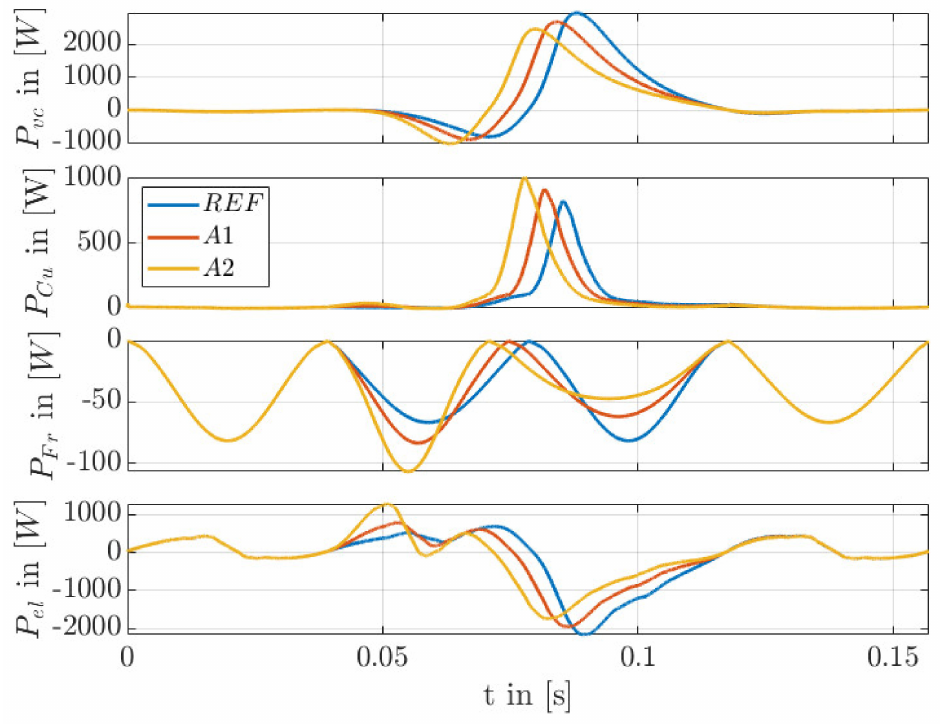
Figure 18. Comparison of trajectories REF, A1 and A2 related to the energy conversion of the electrical machine: volume change power, copper power losses, friction power losses and electric power depending on